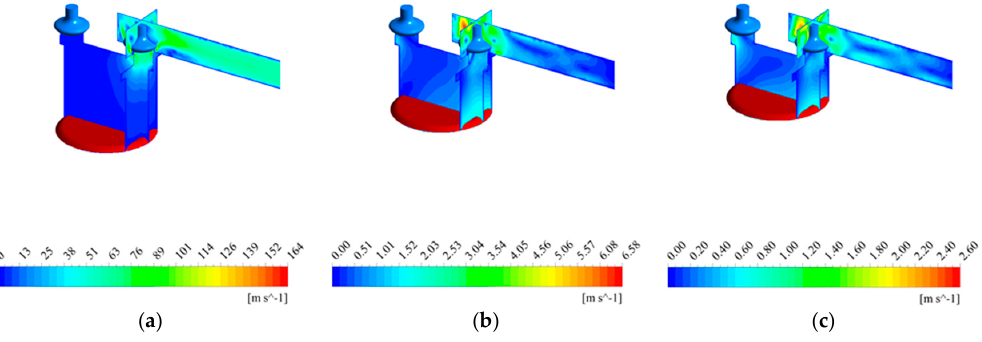
Figure 9. Velocity distribution during the exhaust process: ( a ) θ = 185°; ( b ) θ = 245°; ( c ) θ = 275°.